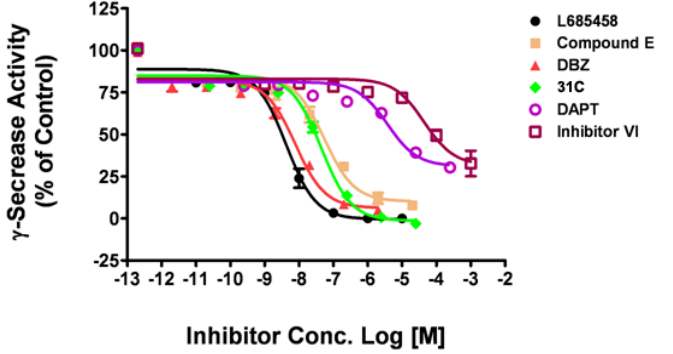
Figure 3. Dose-response curves of known inhibitors against human γ -secretase. Six γ -secretase inhibitors were tested on human γ -secretase obtained from HEK293T cell membrane with the fluorogenic substrate assay. Data are mean ± SEM (n ≥ 3).